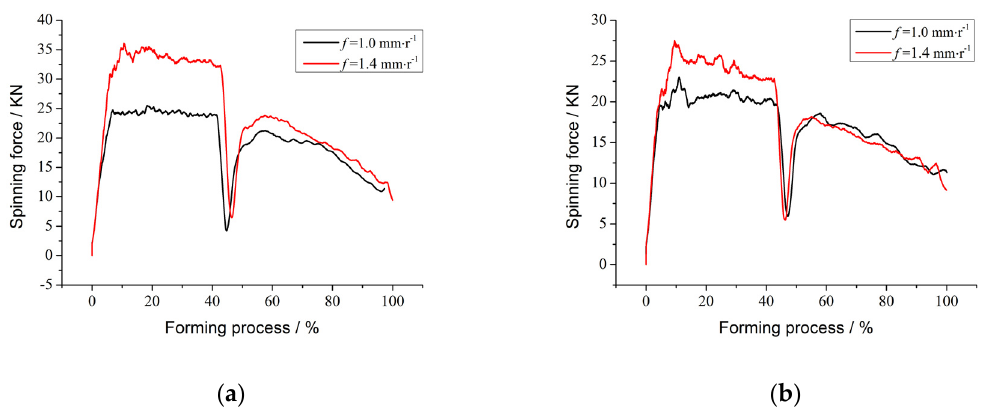
Figure 10. The change of the spinning force when δ = 2.5%: ( a ) ω = 320 r / min; and ( b ) ω = 450 r / min.